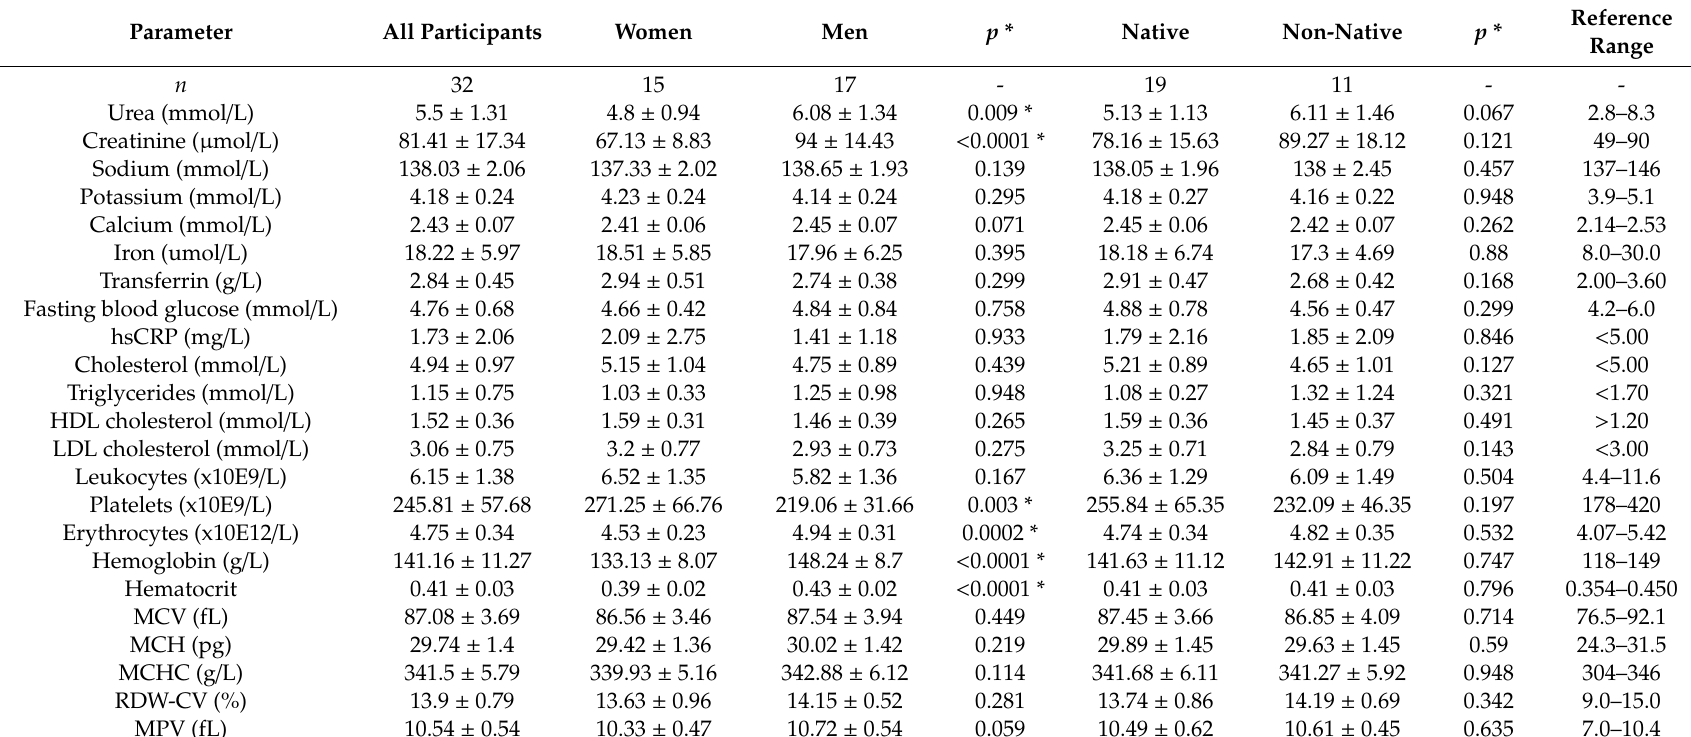
Table 2. Biochemical characteristics of study